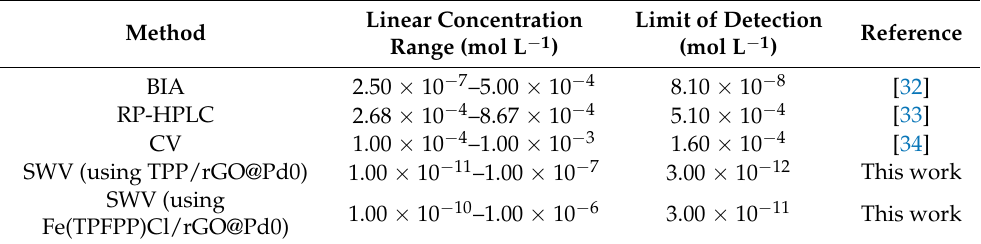
Table 4. Comparison between performances of other analytical methods and the proposed electro- chemical